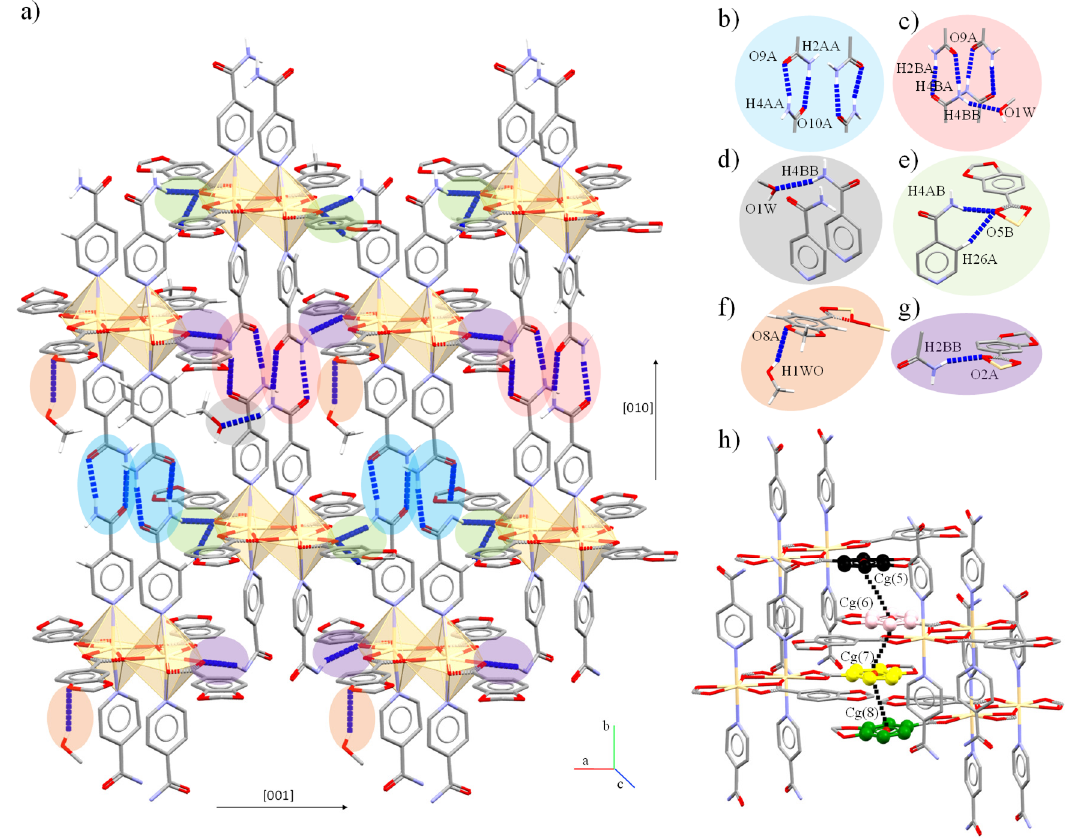
Figure 7. Intermolecular ( a ) N-H···O interactions of 4 . In detail, ( b ) amide···amide interactions be- tween A dimers or ( c ) between B dimers; ( d ) MeOH···amide, ( e ) amide(A)···Pip(B) or ( f ) MeOH···Pip c ) between B dimers; ( d ) MeOH · · · amide, ( e ) amide(A) · · · Pip(B) or association; and ( g ) amide(B)···Pip(A) interactions. ( h ) π ··· π interactions between Pip rings. tions between A dimers or ( ( f ) MeOH · · · Pip association; and ( g ) amide(B) · · · Pip(A) interactions. ( h ) π · · · π interactions between Pip